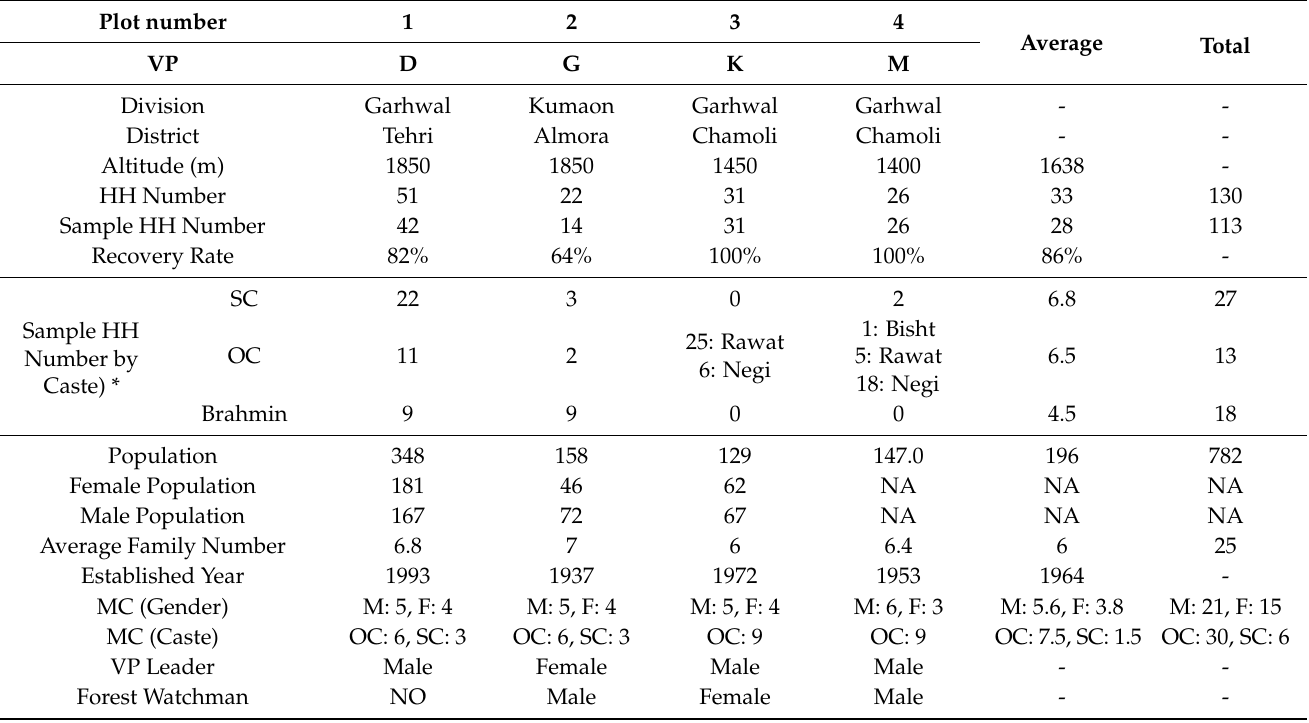
Table 3. Information of the field locations/sites in